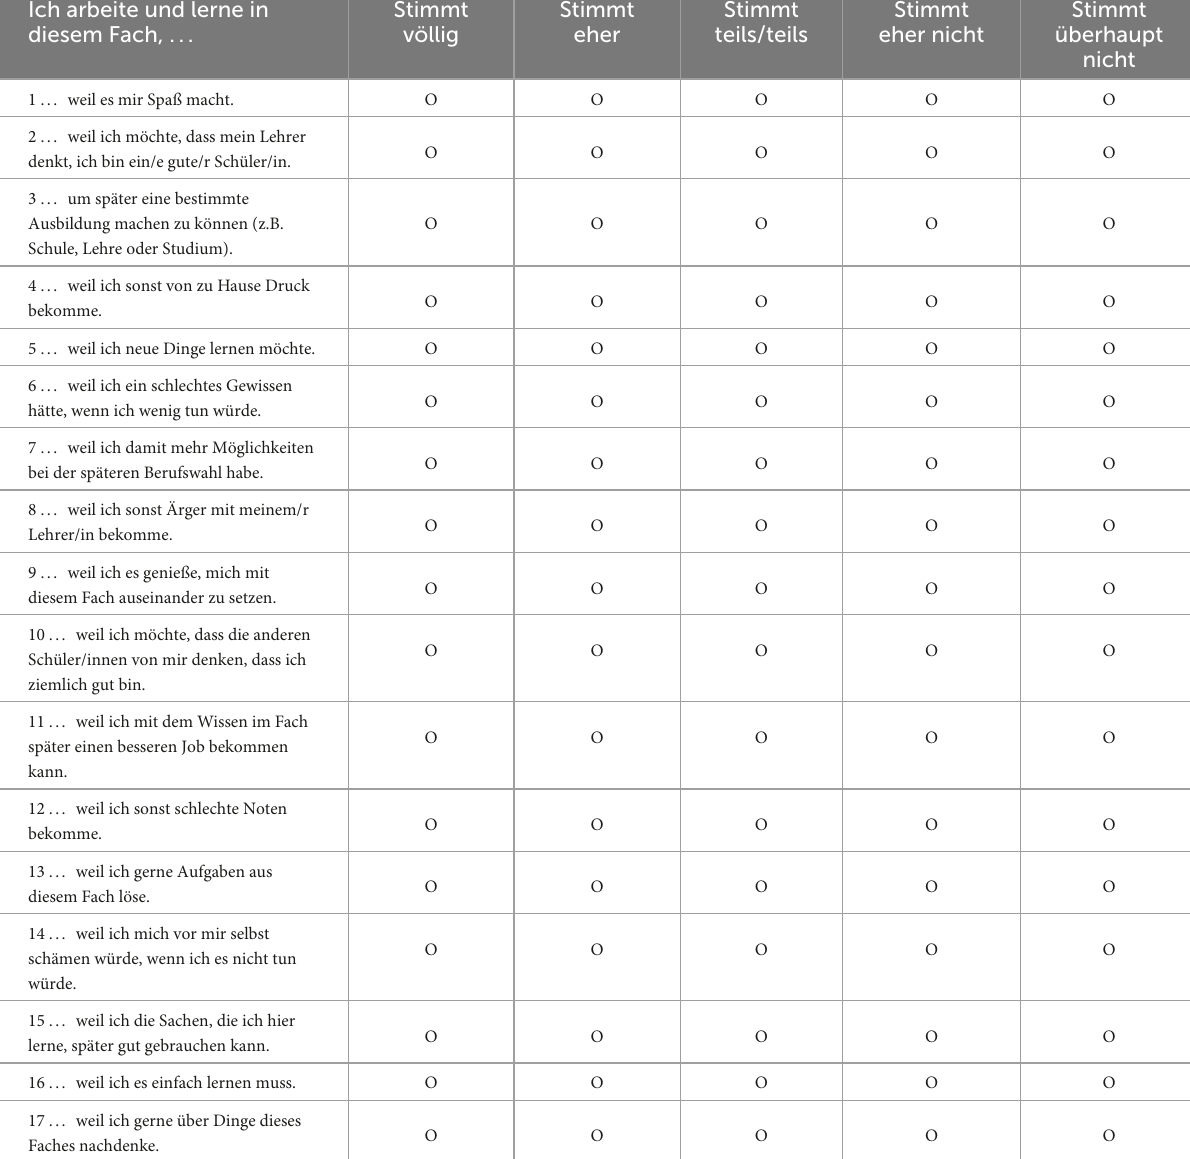
TABLE 3 The scale (Müller et al., 2007) used for the empirical application ( Appendix A ). Ich arbeite und lerne in diesem Fach, ...